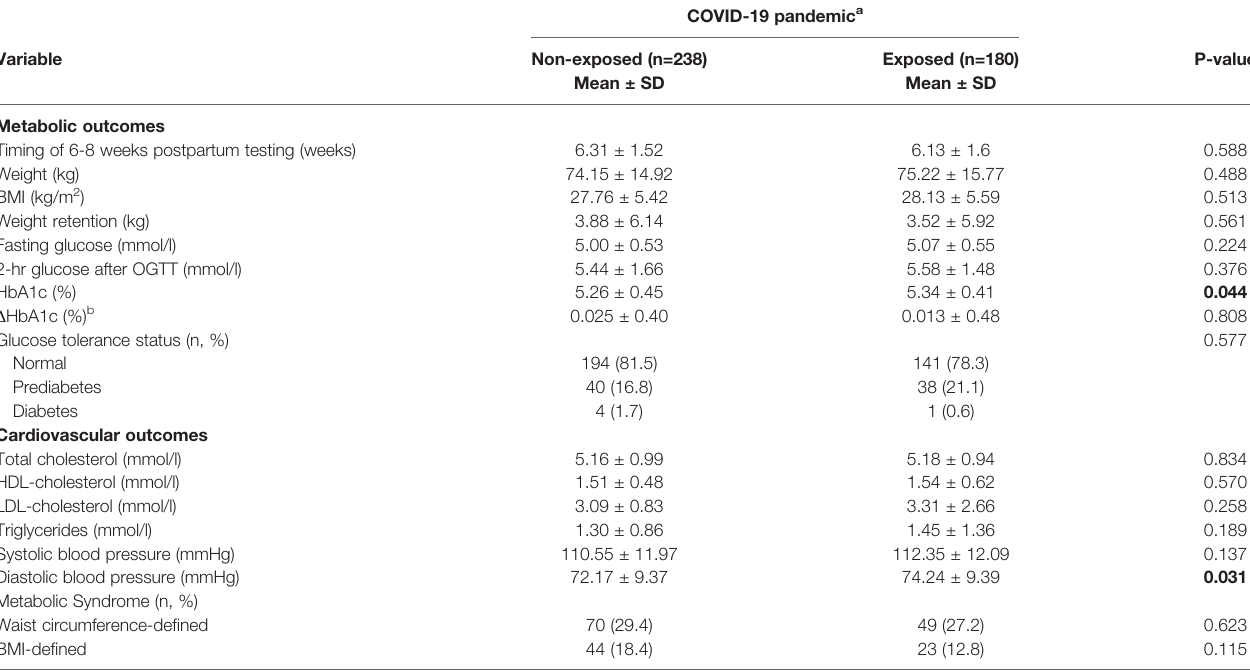
TABLE 2 | Maternal cardio-metabolic health outcomes in the postpartum a year before and during the